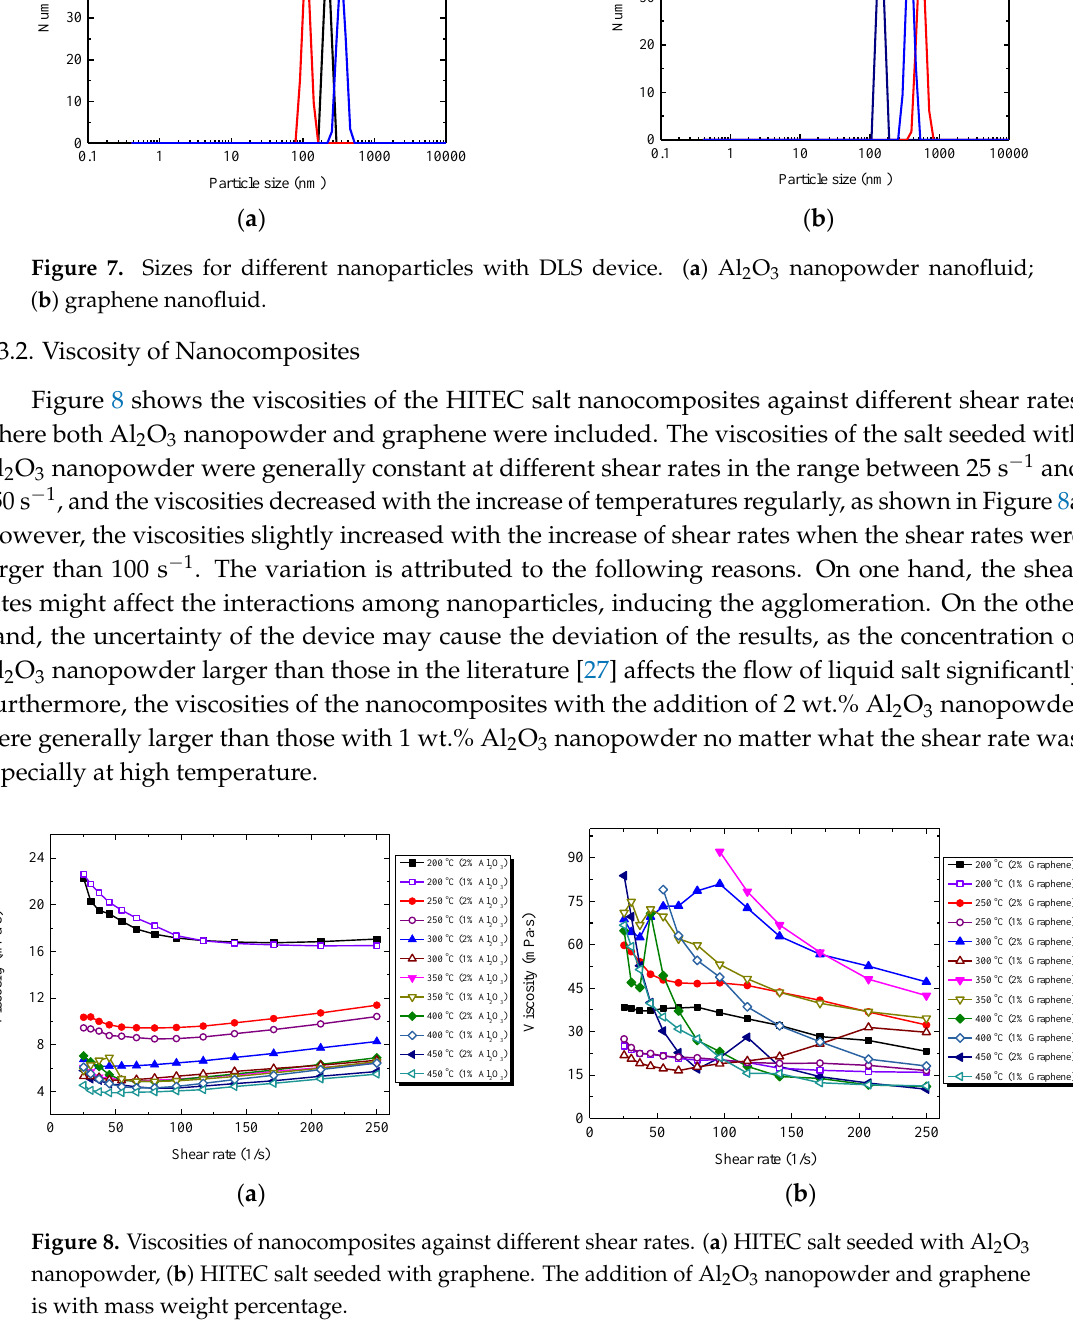
( b ) Figure 9. Viscosities of nanocomposites against different shear rates. ( a ) solar salt seeded with Al 2 O 3 nanopowder, ( b ) solar salt seeded with graphene. The addition of Al 2 O 3 nanopowder and graphene is with mass weight percentage. In a preliminary DSC tests, no obvious change of heat flow was found from the melting phase change temperature to 500 °C, indicating that there was no chemical reaction between graphene and salt. But the addition of graphene leads to a remarkable increase of viscosities, e.g., the addition of 2 wt.% graphene into HITEC salt causes an increase of 77.0%, 232.5%, 751.4%, 987.3%, 528.2% and 550.2% for 200 °C, 250 °C, 300 °C, 350 °C, 400 °C and 450 °C, respectively, while the addition of 2 wt.% graphene into solar salt causes an increase of 50.5%, 247.9%, 176.8%, 39.1%, 3.2% and 5.1% for 250 °C, 300 °C, 350 °C, 400 °C, 450 °C and 500 °C, respectively. The difference can be attributed to different sizes and shapes of the nanoparticles. It was found that the average size of graphene was larger than that of Al 2 O 3 nanopowder, as mentioned previously in Section 3.3.1. The larger size of the nanoparticle would restrict the flow of liquid salt and increase the viscosity correspondingly. Besides the difference of the nanoparticle size, the different structural characteristics between graphene and Al 2 O 3 nanopowder shown in the literature [37,38] also affect the viscosity of the nanocomposites. In accordance with Figure 8b and Figure 9b, the large increment in viscosity indicates that HITEC salt seeded with graphene shows non-Newtonian behaviour slightly. In all, the viscosity of the salt worked as the HTF in a CSP system is related to the pump power in the plant, the addition of the nanoparticles induce large viscosities and are likely to raise the cost